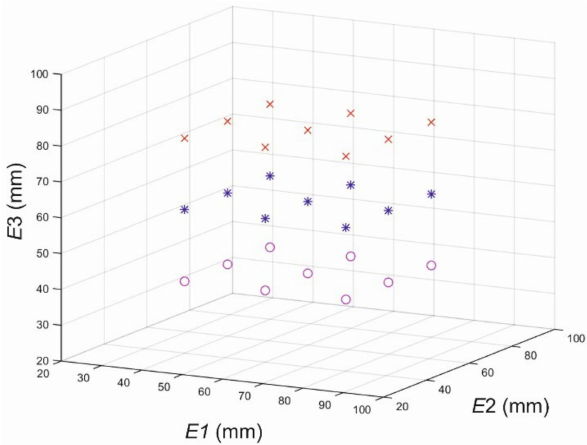
Figure 4. Three dimensional plot for the E 1– E 3 utilized